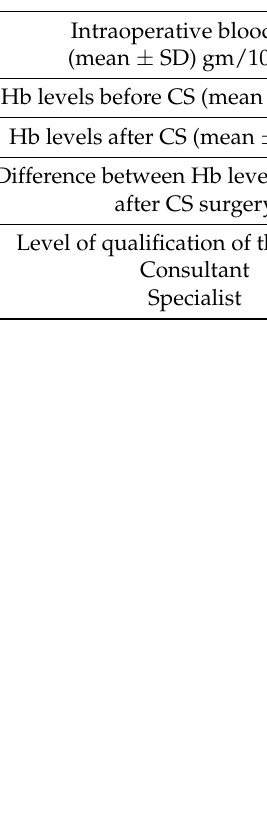
Table 3. Urological injuries occurring during CS: site, diagnosis, and